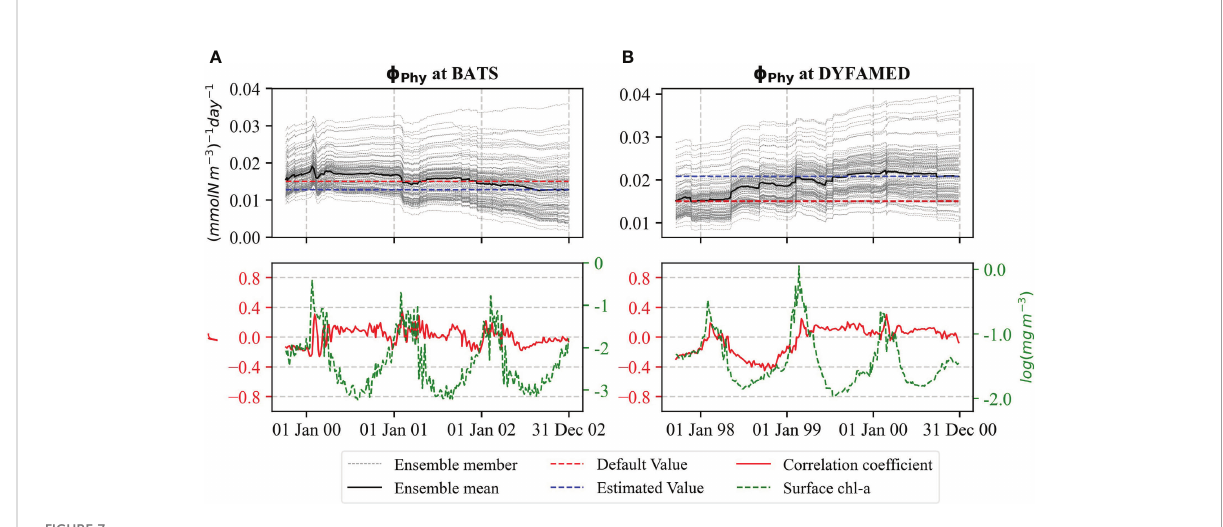
FIGURE 7 Evaluation of ∅ Phy for (A) BATS and (B) DYFAMED analogous to Figure 4.